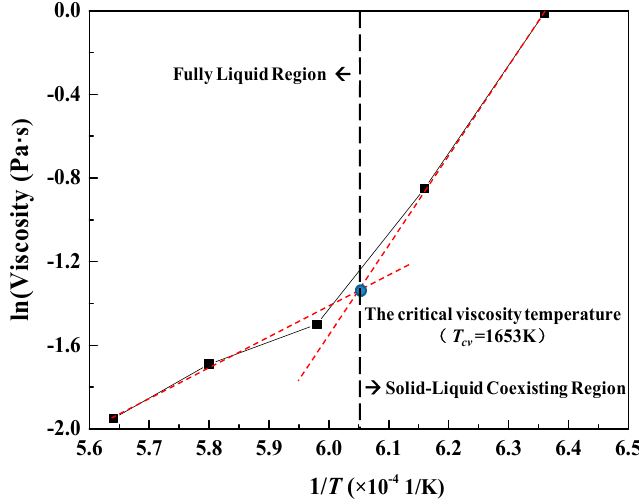
Figure 8. Example of the critical viscosity temperature for the CaO-SiO 2 - FeO-MgO system at the basicity of 0.38. Note the critical viscosity temperature is 1380 °C (1653 K).